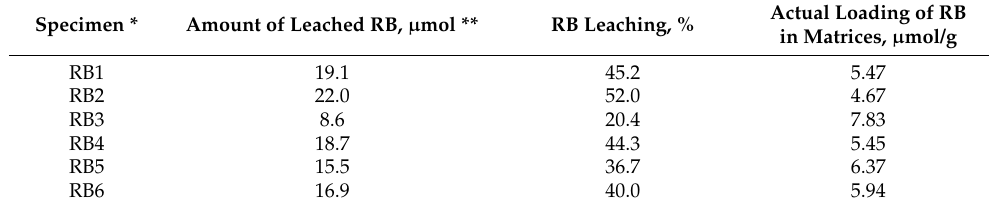
Figure 2. Photographic image of the specimen RB6@OR@LLDPE (RB6 immobilized onto LLDPE by thermal adhesion) ( a ); SEM micrographs of surfaces of RB6 powder ( b ), and of RB6@OR@LLDPE ( c ); a cross-section of RB6@OR@LLDPE ( d ). Table 2. Leaching of RB from RB@ORMOSIL